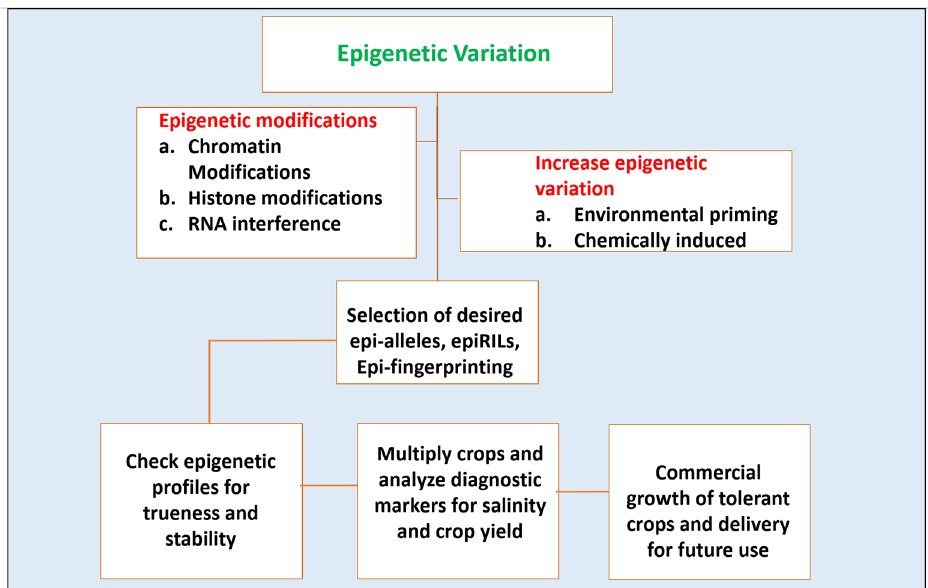
Figure 3. A schematic representation of the idea of epigenetic breeding for raising salinity-tolerant crop plants.